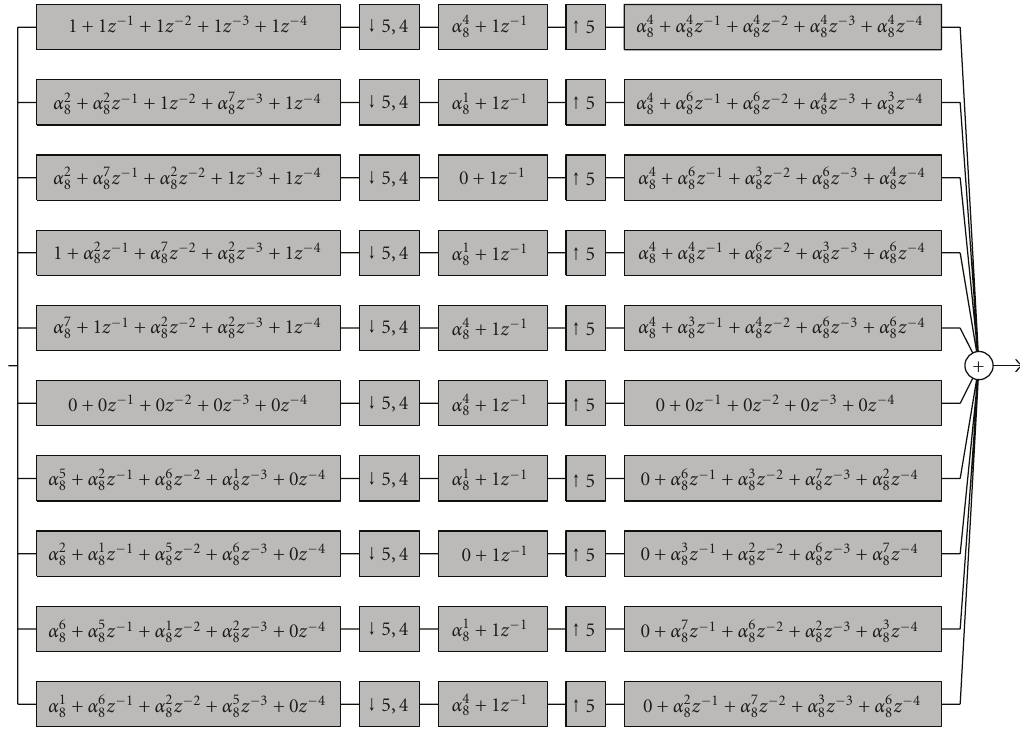
Figure 6: Critically subsampled filter bank representation over F q of the BCH code B [10,5] ( n = 2).